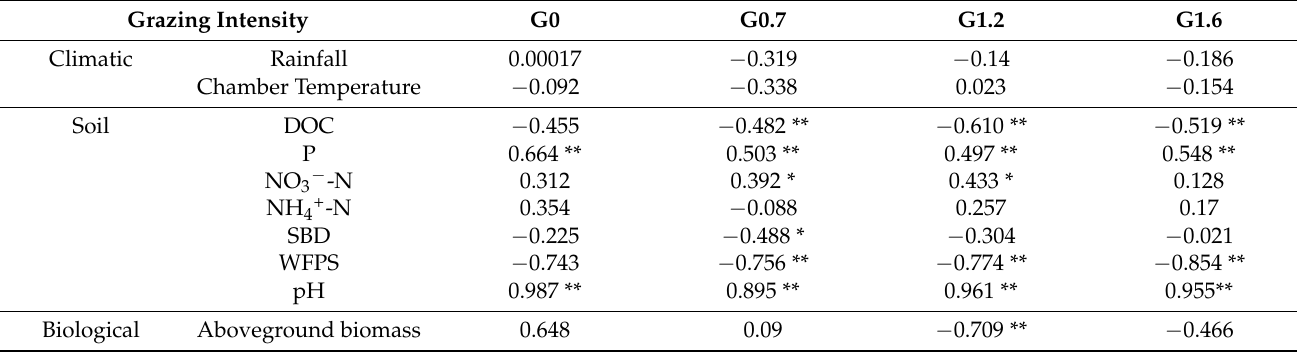
Table 2. Pearson relationships between climate factor (rainfall and chamber temperature), soil factor (DOC, P, NO 3 − -N, NH 4+ -N, SBD, WFPS, pH) biological factor (aboveground biomass), and the monthly mean flux rates of N 2 O under different grazing